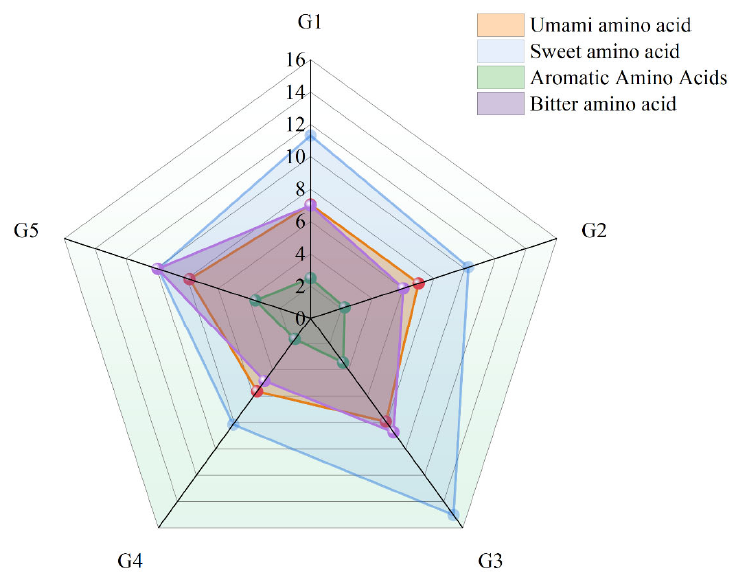
Figure 3. Radar chart of FAAs in pickled BLS with different salt